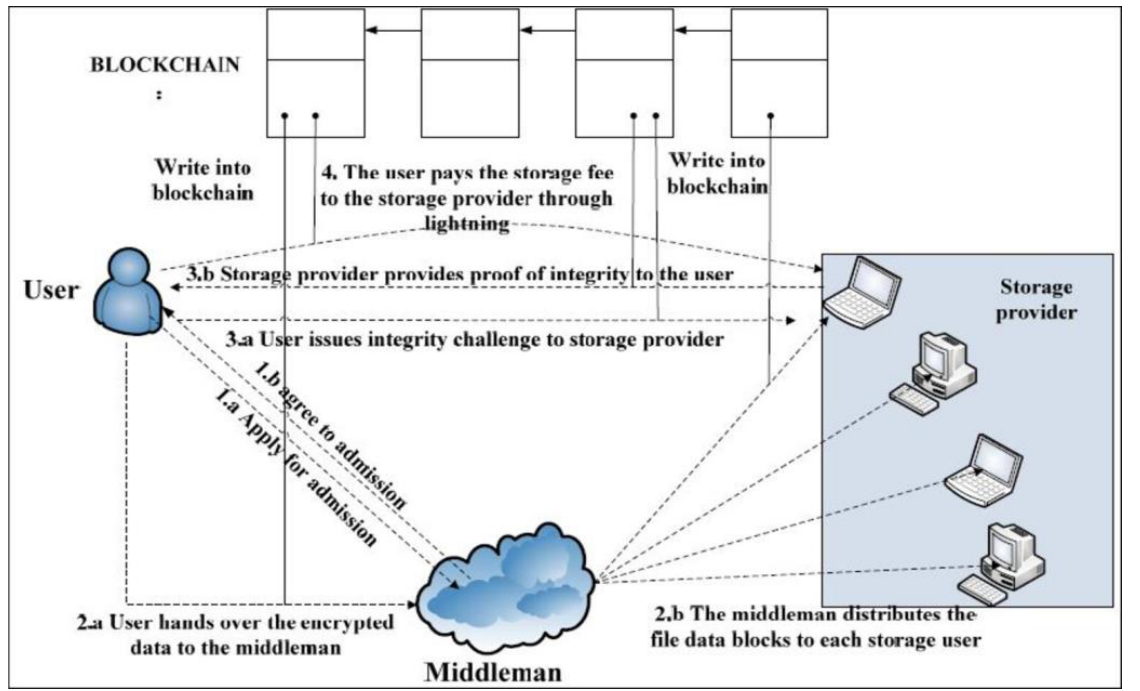
Figure 2. Decentralized cloud storage system design [10]